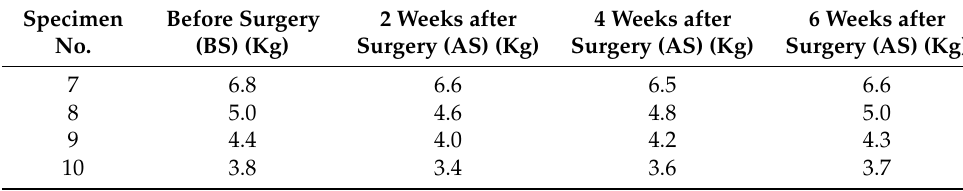
Figure 12. Weight distribution and comparison amongst cases from group 2 at 2, 4, and 6 weeks (AS) as well as (BS). Table 5. Weight distribution of the cases, before and after surgery, in group two.